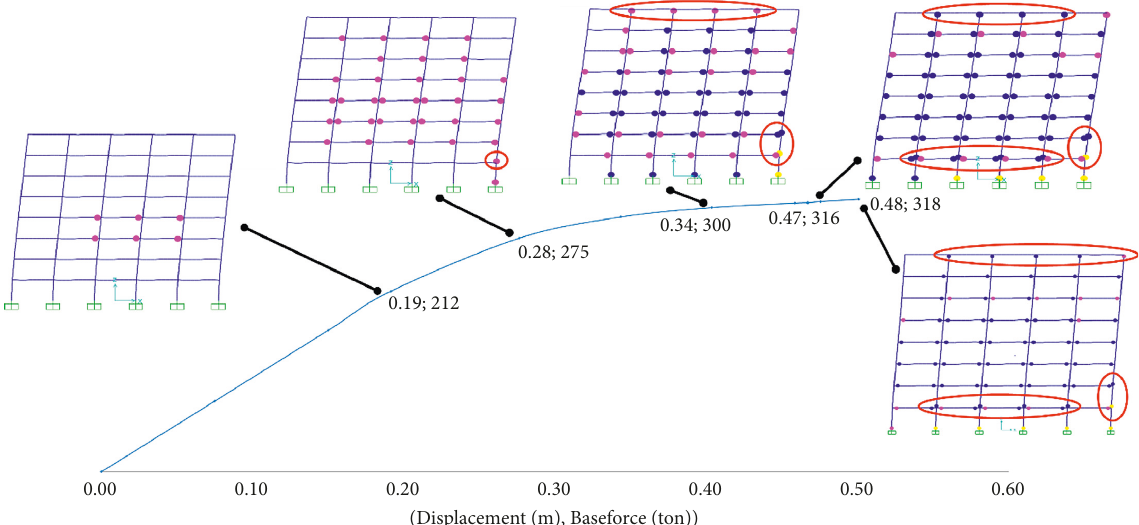
Figure 13: Pushover graph of an 8-story frame designed by the LRFD